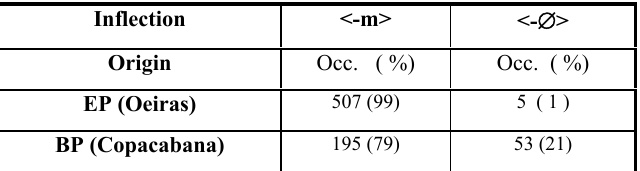
Table V – Third person null subjects vs inflection in EP and BP Inflection